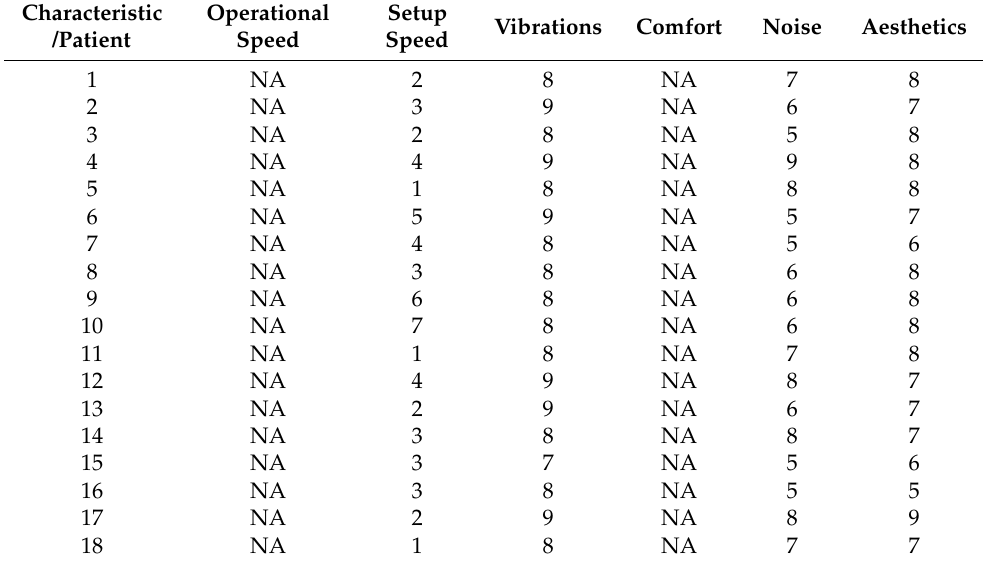
Table 2. Height adjustment module.